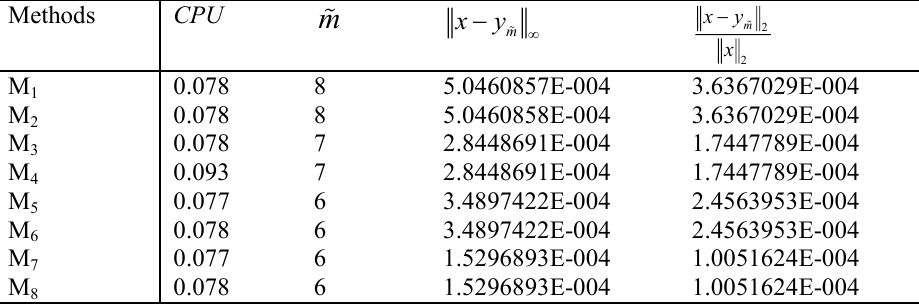
Table.3. CPU times in seconds, iteration numbers m and relative norms of the errors obtained by Algorithm 1 using the methods , 1,...,8 M i  for the Phillip’s problem i